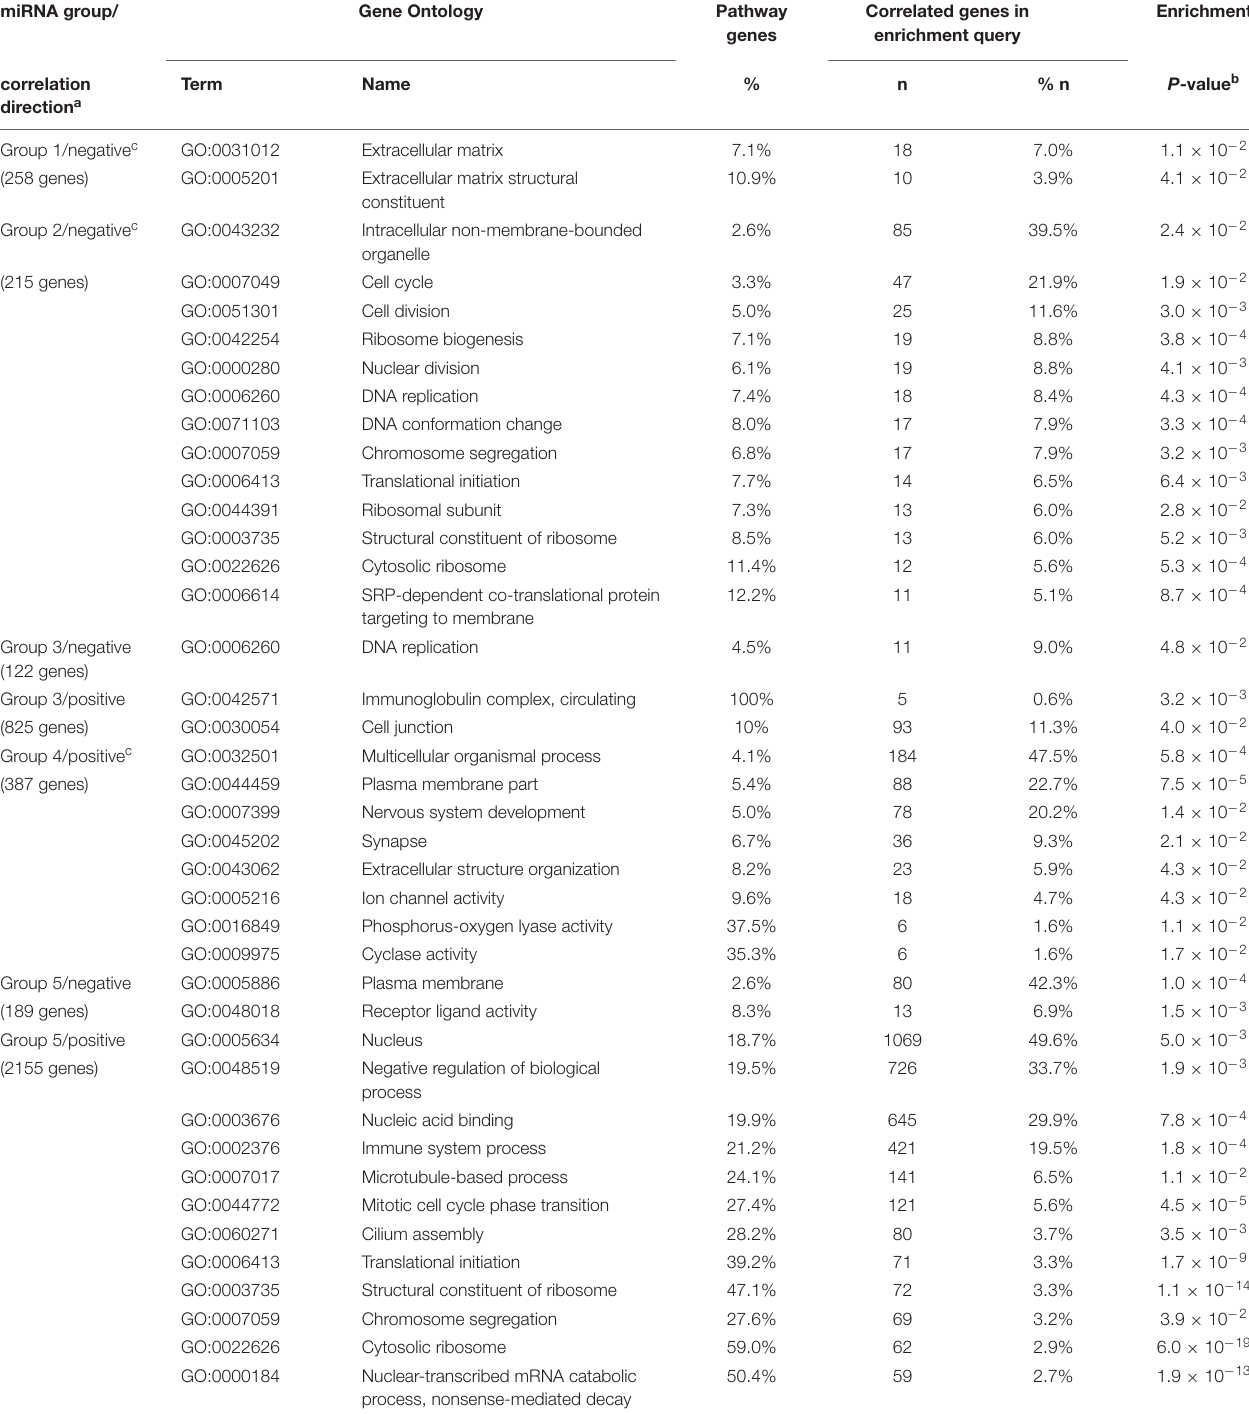
TABLE 4 | Functional enrichment of genes showing correlated expression in term placentas with 66 preeclampsia linked DEmiRs. miRNA group/ Gene Ontology Pathway